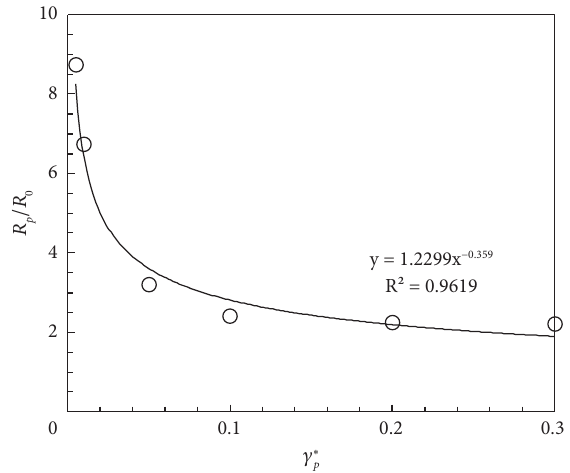
Figure 7: Relationship between R